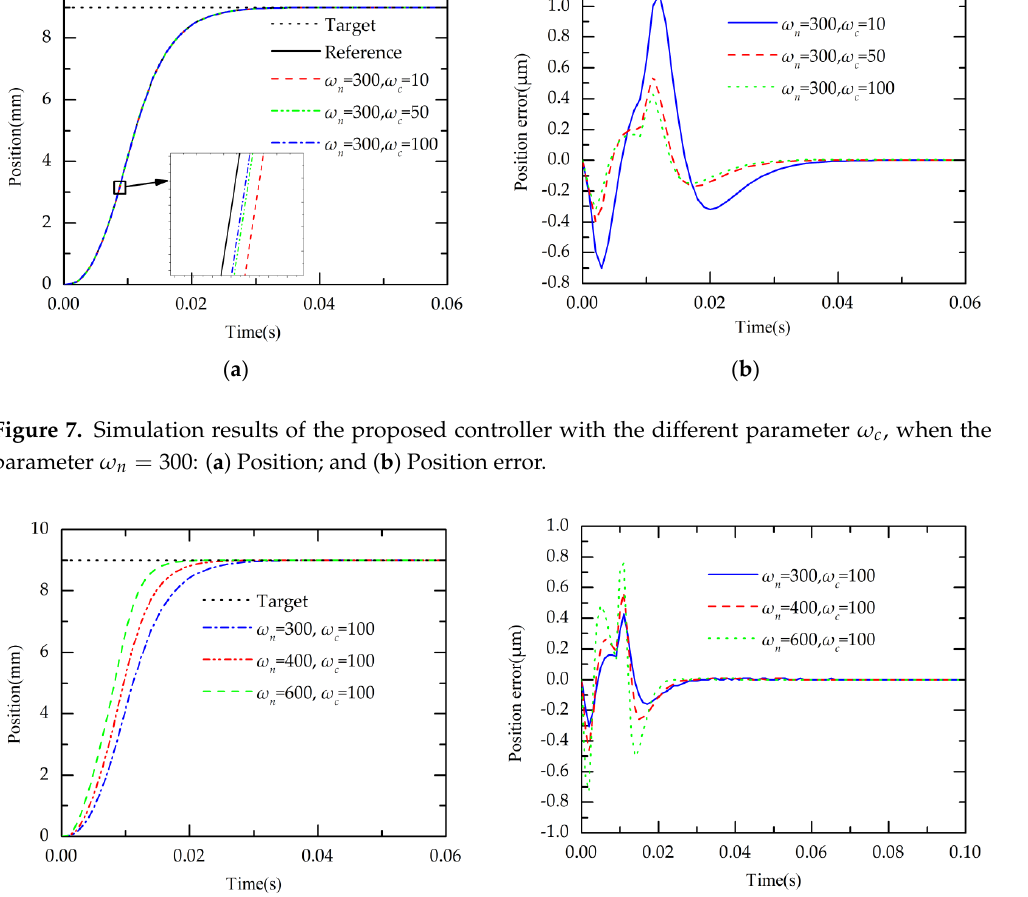
ω , when the ω , when the n n